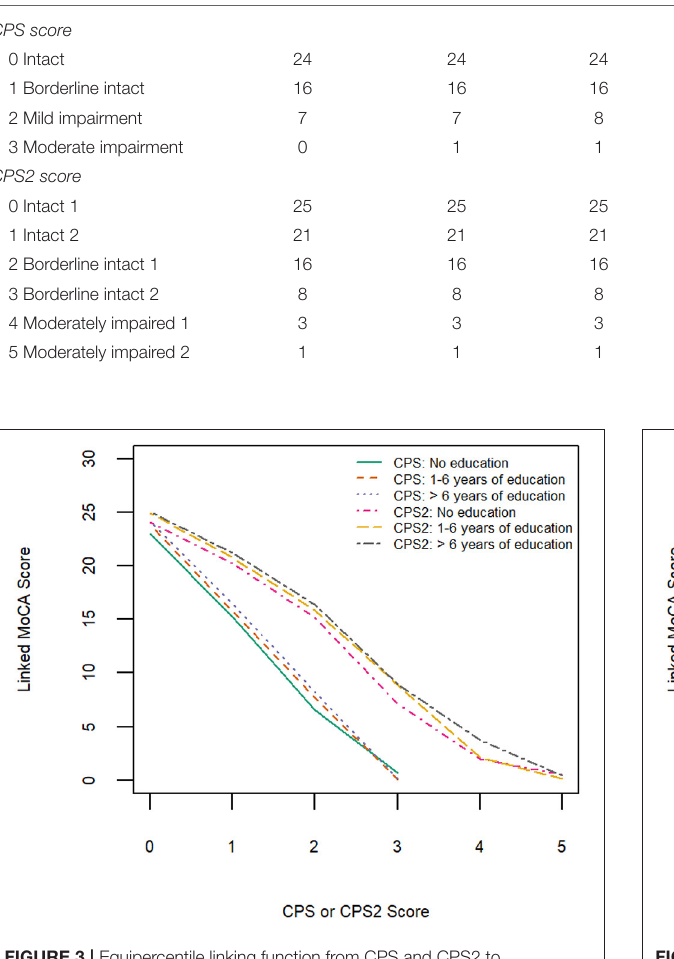
scales used in diverse settings and different research